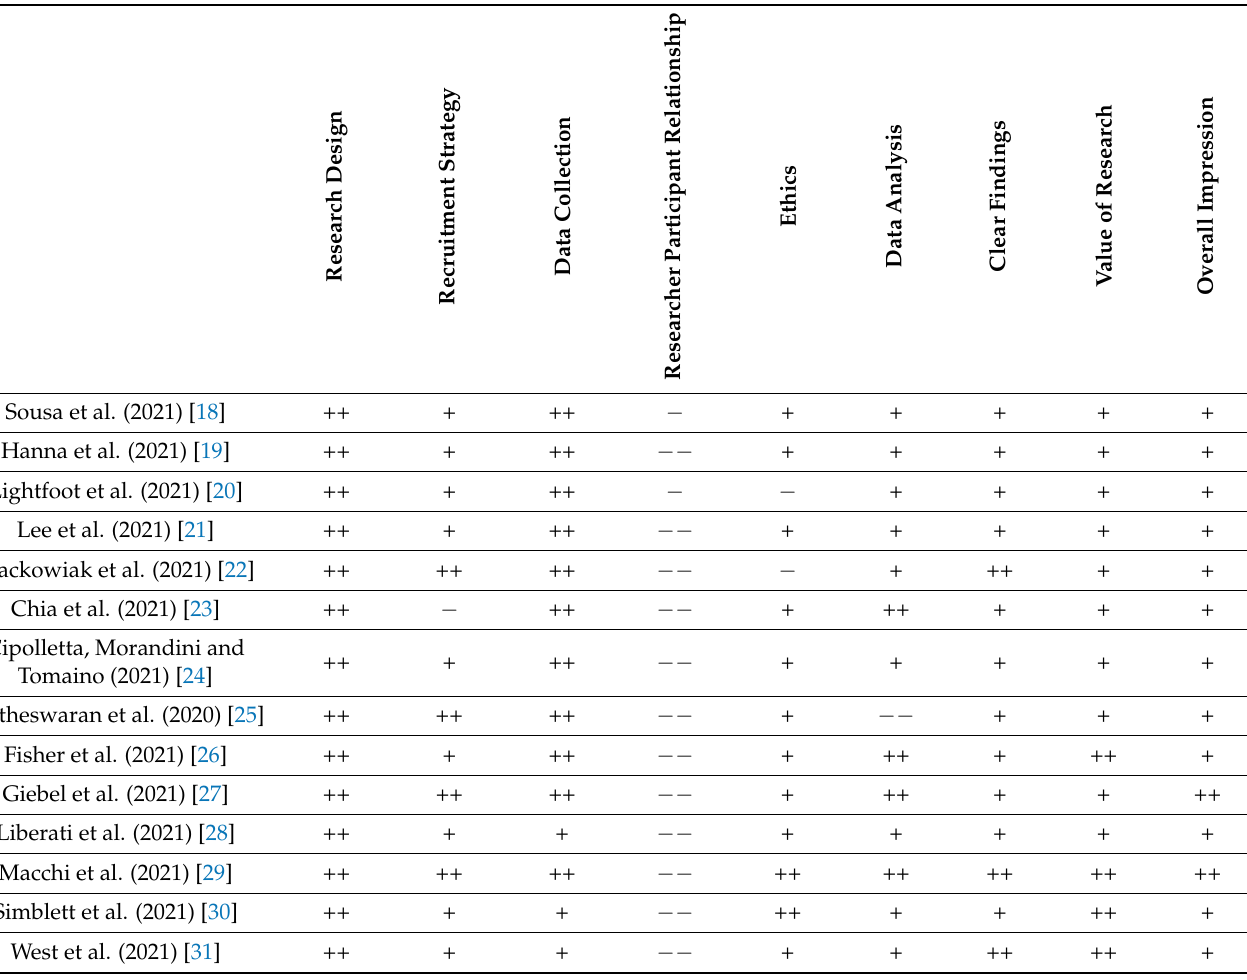
Table 2. Summary of critical